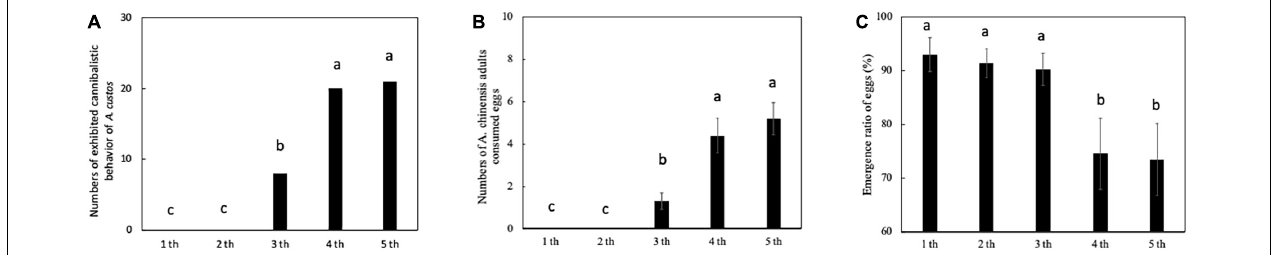
emergence ratios in the first, second, and third instar nymph experiments were significantly higher than the fourth and fifth instar nymph experiments ( Figure 4C : Tukey HSD test, All, p <